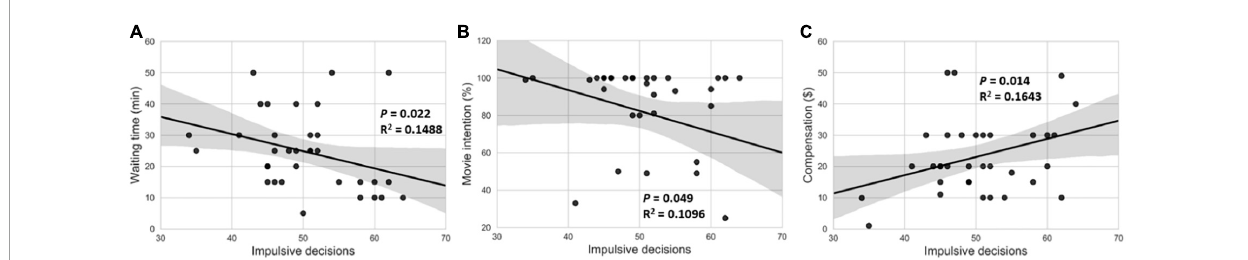
FIGURE3 Correlation between impulsive decision-making and impulsive purchase intention in the smartphone separation condition. Impulsive decisions (A) significantly negatively correlated with the amount of time they were willing to wait for a restaurant, (B) negatively correlated with the intention of watching a movie after a critical deadline, and (C) positively correlated with the expected value of a compensation